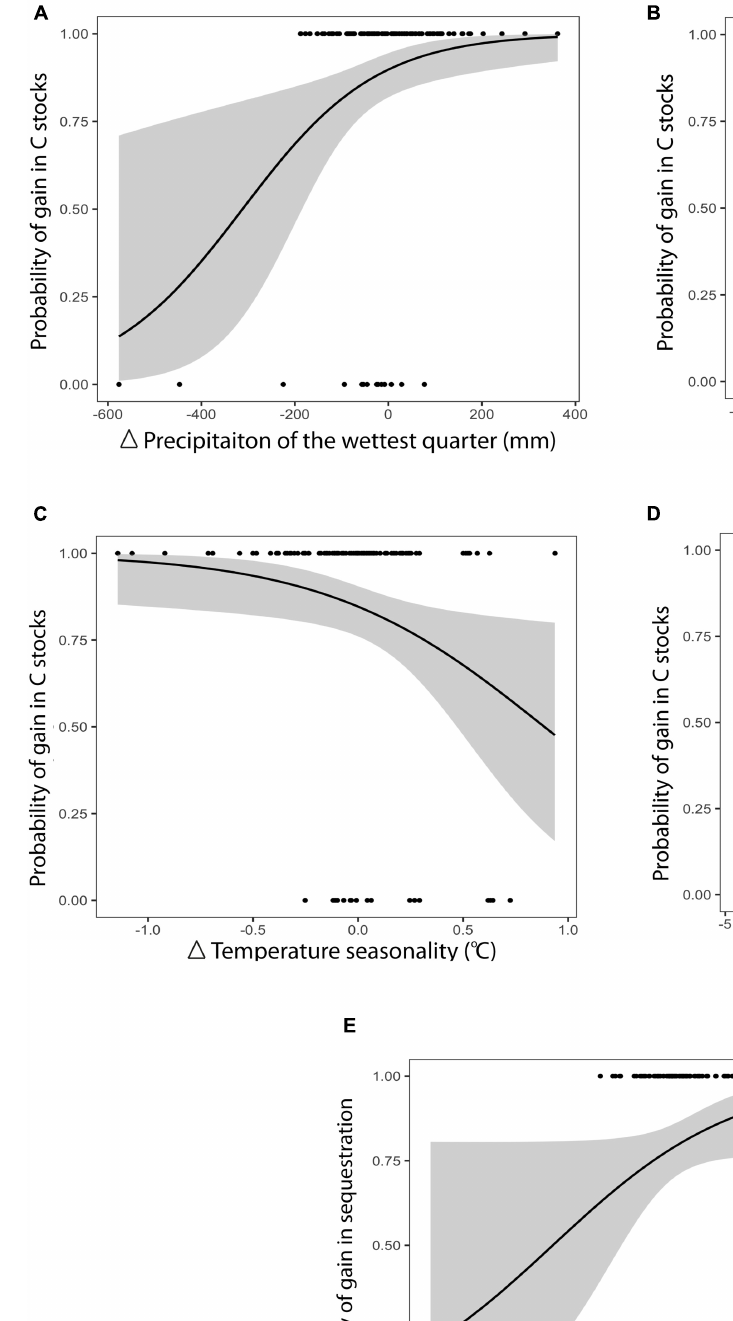
Frontiers in Marine Science |